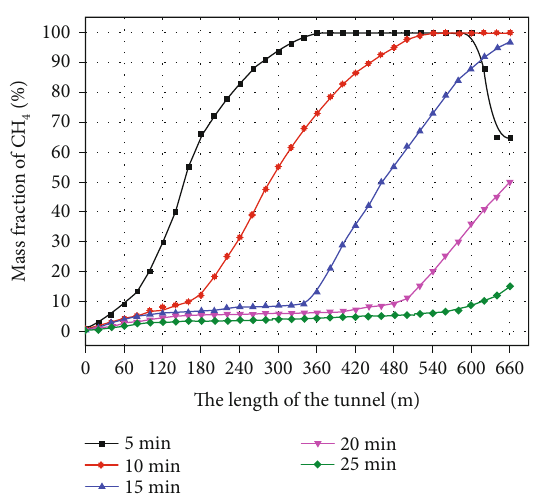
Figure 7: CH concentration distribution in the tunnel (Case 1). 4